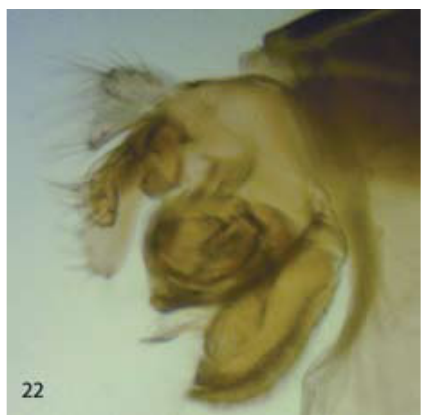
Fig. 22. Rhynchomicropteron species 4 male, right face of